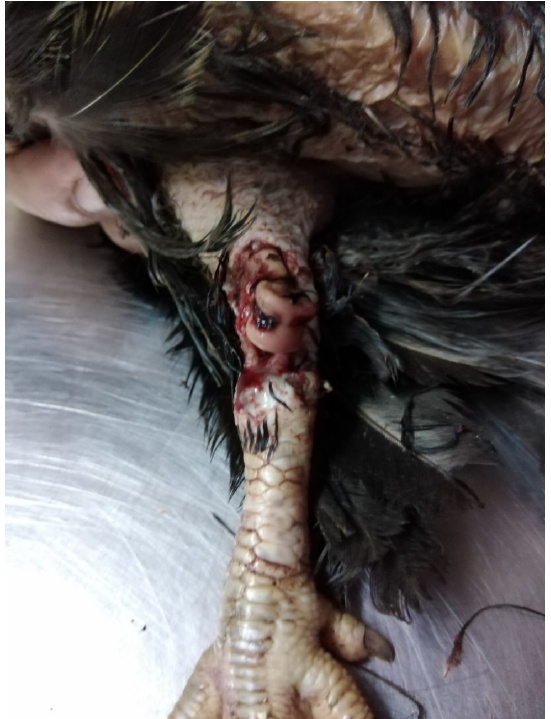
Fig. 1. The lacerated wound at tibiometatarsal joint